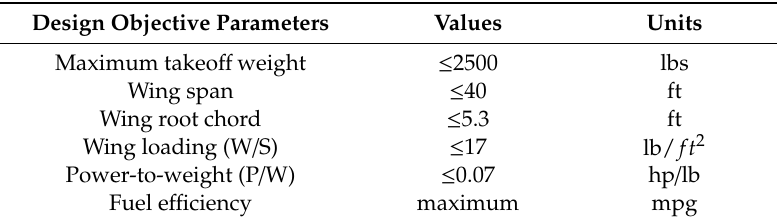
Table 1. Design objective parameter target